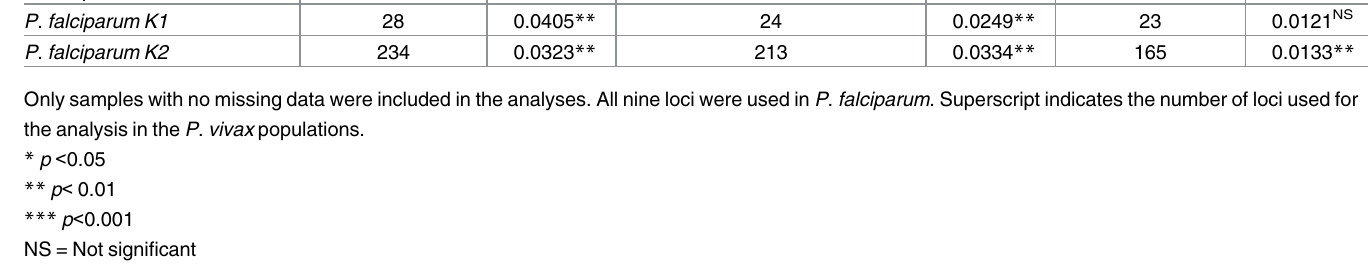
infections (8.8% (6/68)), were shared between members of the same household. Seven pairs of infections (35.3%, (24/68)) were less than 1 Km apart. The median distance between infections was 5.3 Km (range 2 meters to 19.5 Km) (S2 Fig).